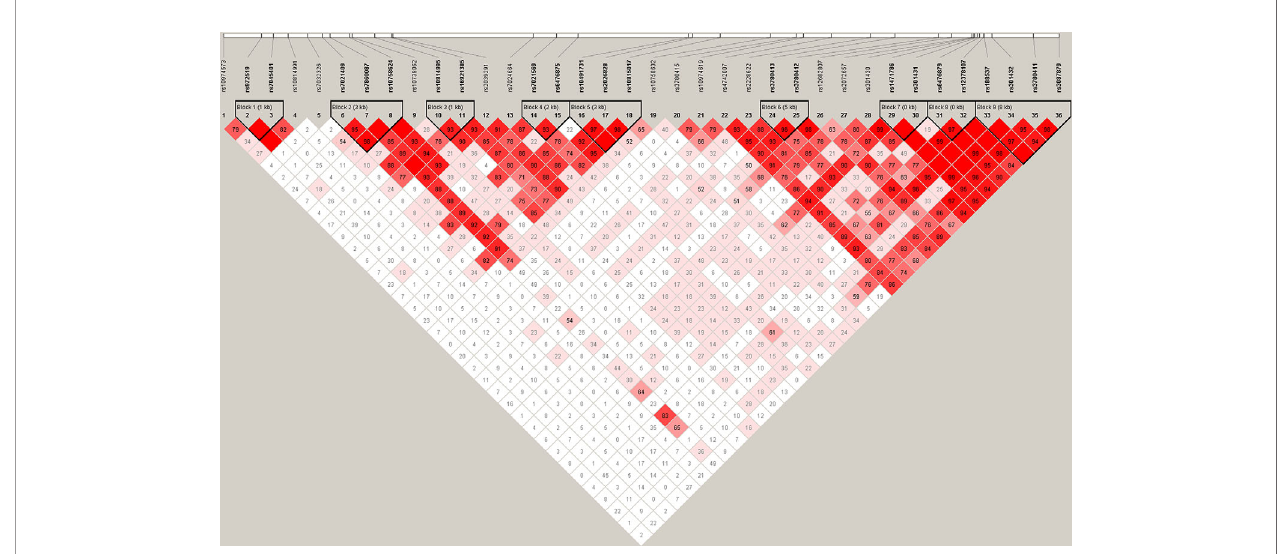
FIGURE 1 | Haplotype block structure of the SLC1A1 gene in both SZ patients and HCs. The index association SNP is represented by a diamond. The colors of the remaining SNPs (circles) indicate LD with the index SNP based on pairwise r 2 values from our data.